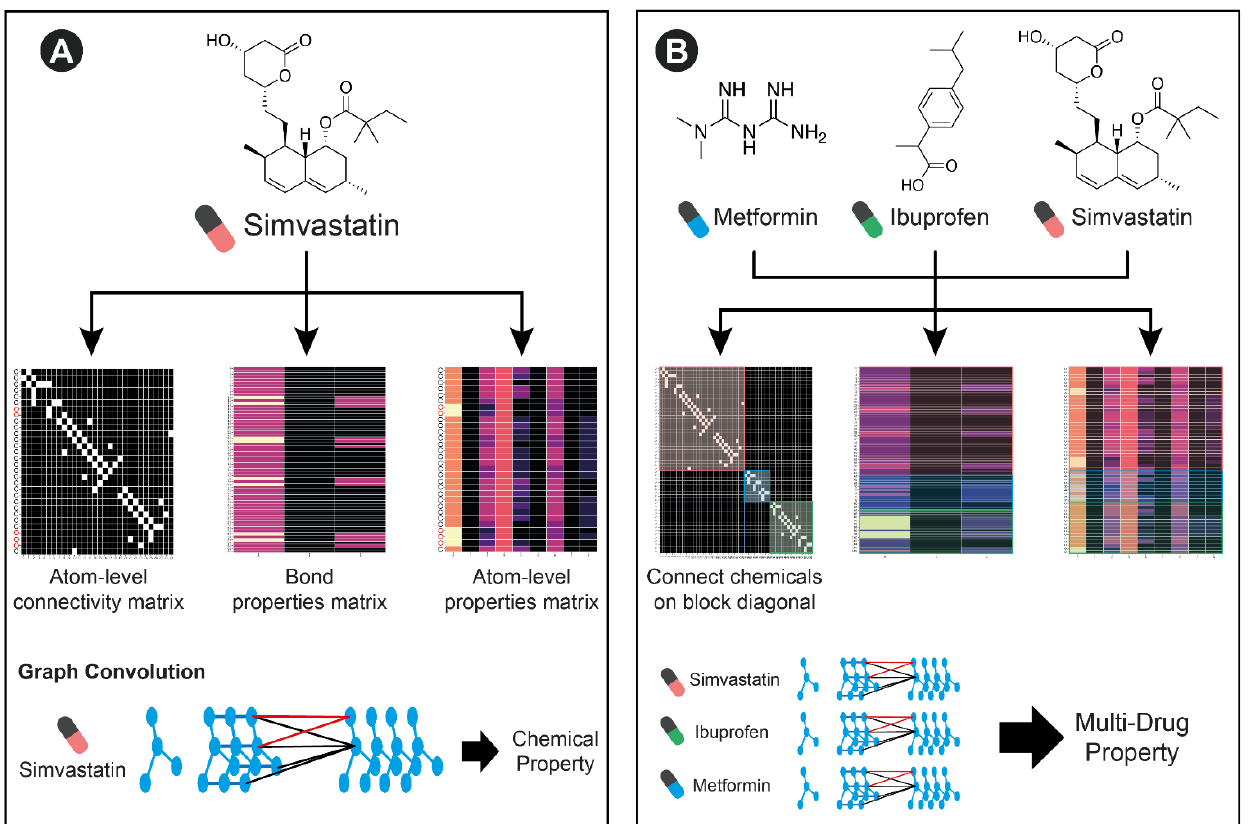
Figure 2. An overview of the multi-drug GCN architecture: ( A ) A standard GCN applied to a chemical structure creates bond and atom-level features, and an atom-level connectivity matrix to describe the molecule. Graph convolutions are performed to learn new feature representations that learn local structures that can be used to predict chemical properties ( B ) Our multi-drug GCN architecture concatenates the bond and atom- level features and creates a block diagonal connectivity matrix that represents the set of molecules an individual is taking. In a generalization of the single molecule GCN, the multi-drug GCN aggregates information from local structures across all molecules to predict multi-drug properties. We highlight the featurization of an example patient currently taking simvastatin (red pill), ibuprofen (green pill), and metformin (blue pill).